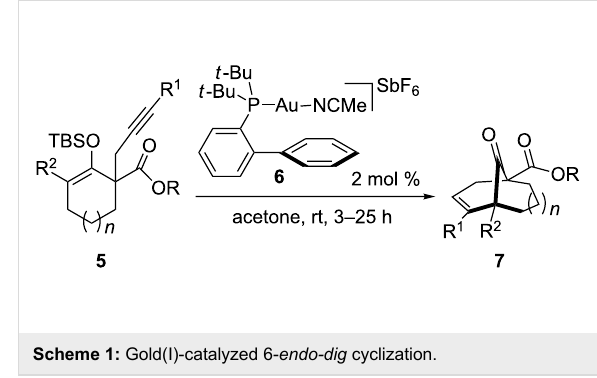
Scheme 1: Gold(I)-catalyzed 6- endo-dig